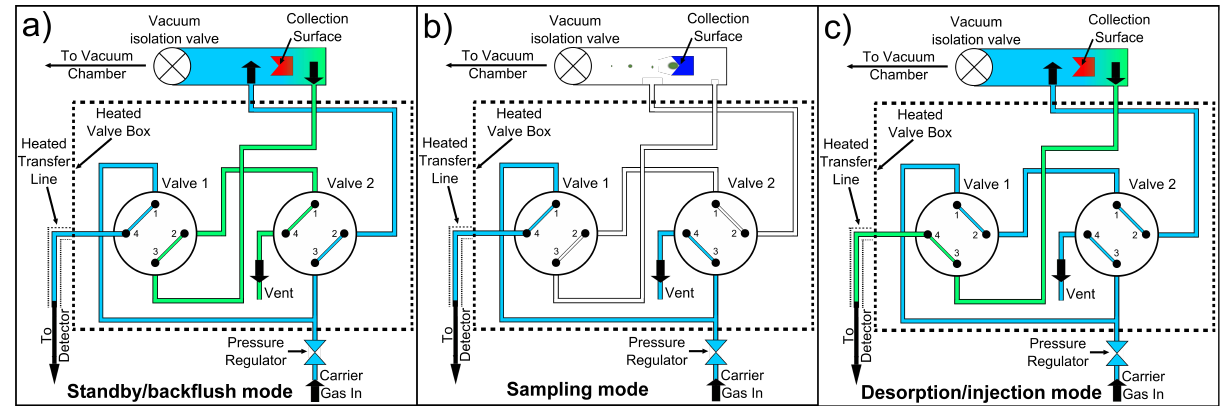
Fig. 2. (a) Standby/backflush mode: the collector and detector are supplied with the carrier gas. For cleaning purpose the collector can be heated (backflush mode). (b) Sampling mode: the collector is separated from the carrier gas supply and the particle beam is directed to the collection surface where the particle sample is accumulated. During sampling the collector is cooled with liquid nitrogen. (c) Des- orption/injection mode: the vacuum isolation valve is closed and the collector heated. The particle sample is desorbed from the collection surface and transferred with the carrier gas stream to the